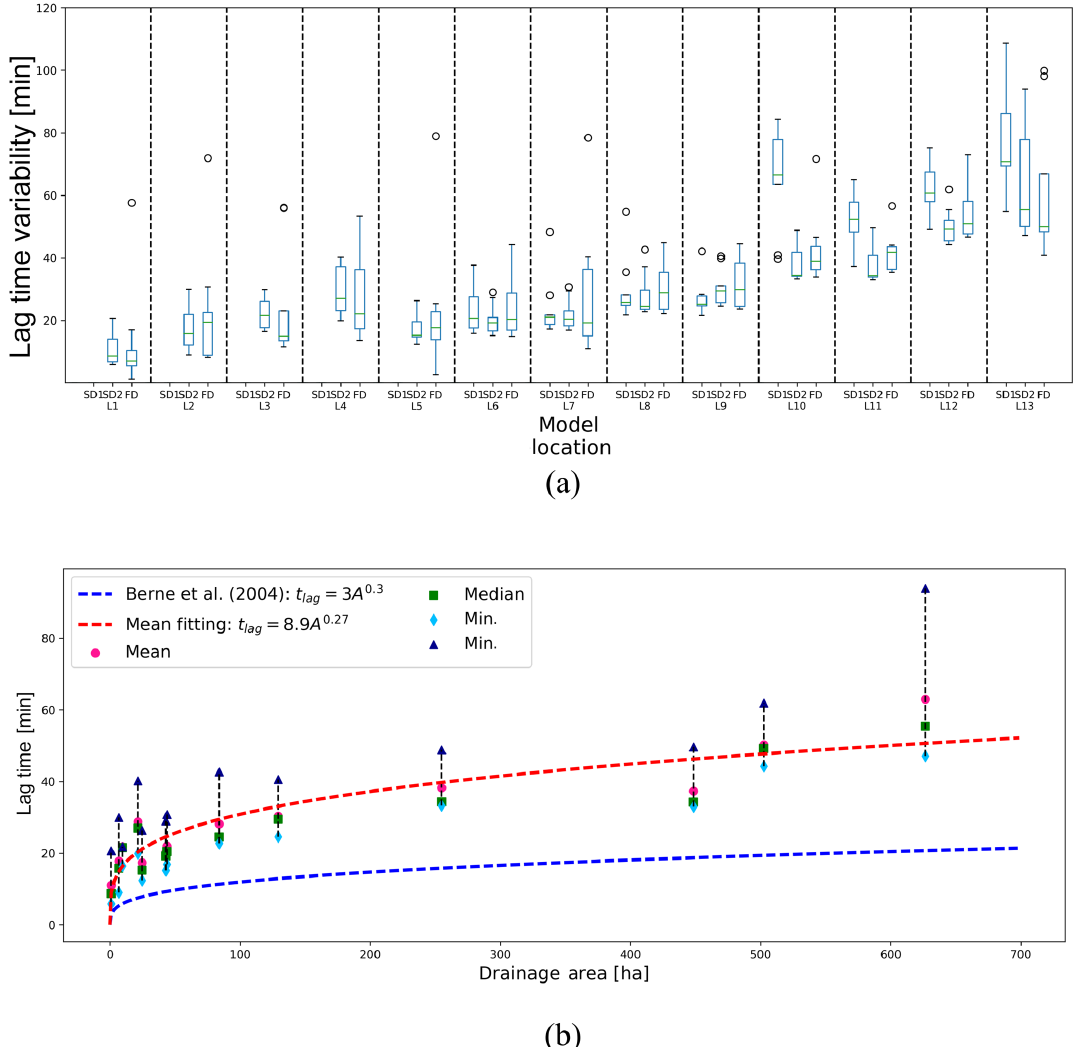
Figure 4. Variability of the lag time, depending on the location, for each model (a) . The box plots represent the median (red line), the upper (third quartile) and lower (first quartile) quartile (boxes boundaries), and 1.5 times the interquartile range below the first and above the third quartile (whiskers). Drainage areas corresponding to each location are presented in Table 2b. Average, median, minimum and maximum value of the lag time as a function of A d for SD2. (b) Fitting power law curves and the power law relation proposed by Berne et al. (2004) are